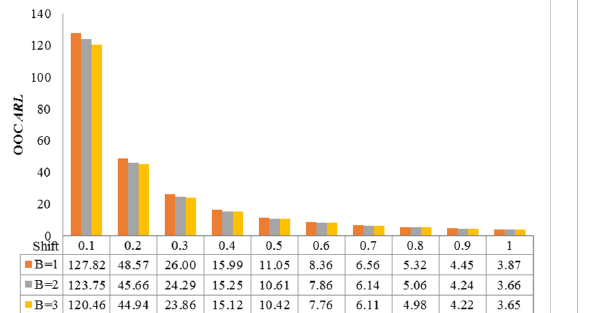
Fig. 3. The 𝐴𝑅𝐿 profiles of the HWMA 𝑋(cid:3364) ∗ scheme (for the mixed-3&4 strategy) with a constant variance when 𝐵 =1, =500 for 𝜆 =0.1, 𝜙 =0.75, 𝛾 =0.75, 𝐿 ∗ =2.938 and 𝐴𝑅𝐿 (cid:2868) different values of